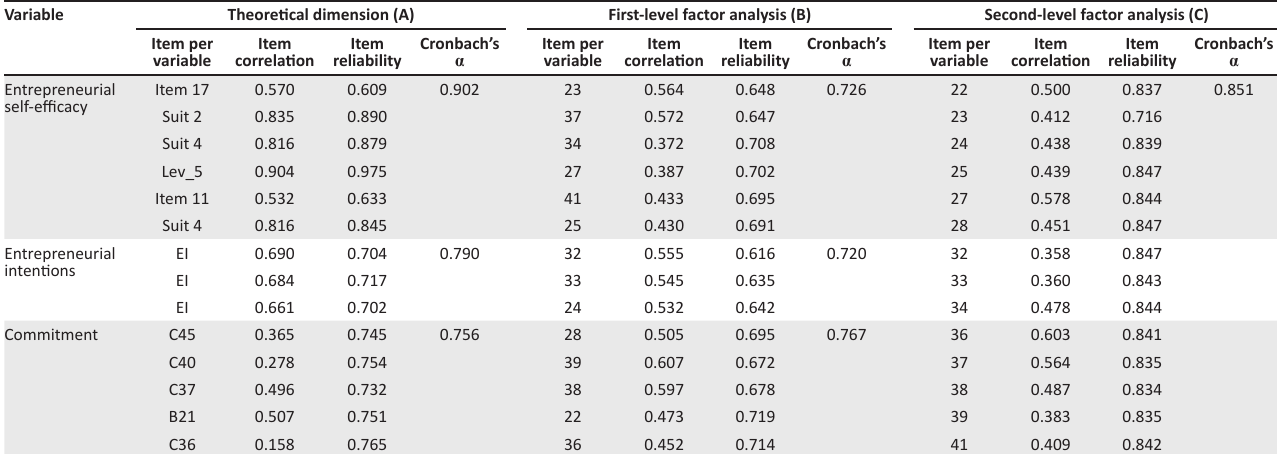
TABLE 2: Summary of exploratory factor analysis.